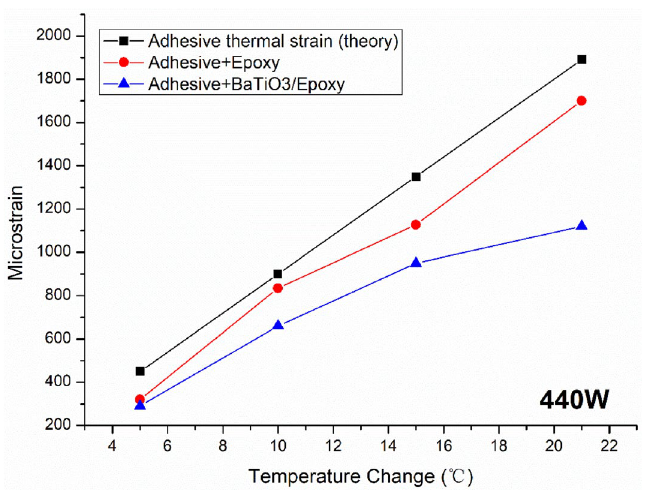
Figure 29. Evolution of micro-strain with temperature rise—theoretically calculated thermal expansion of adhesive (black), actual strain data from sensor 5 of adhesive bonded onto neat epoxy (red), and actual strain data from sensor 1 of adhesive bonded to 15 wt.% BaTiO 3 -epoxy nanocomposite (blue) under 440 W at 5 °C, 10 °C, 15 °C, and 21